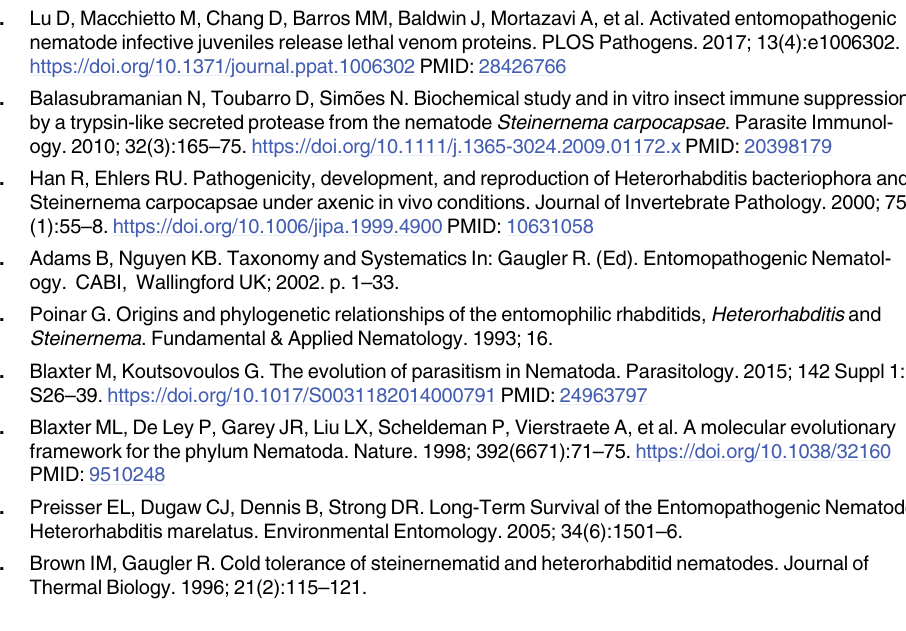
fold transformed abundances of 2